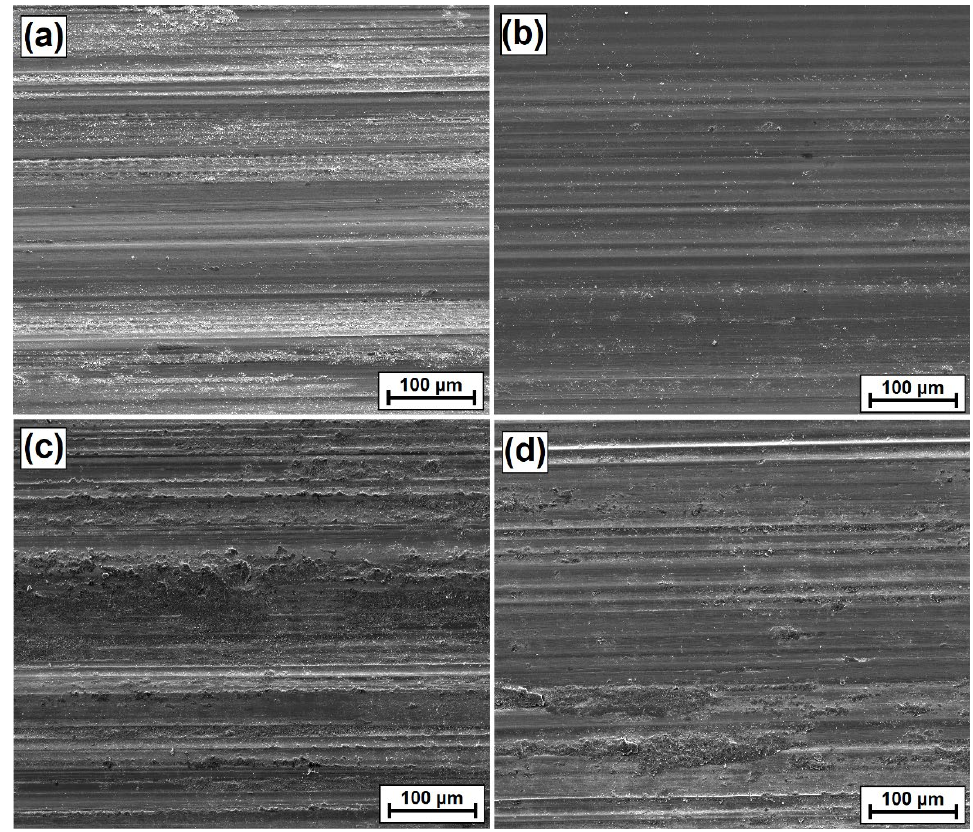
Figure 10. Surface images obtained after a wear resistance test: ( a ) substrate after hardened and tempered processes, ( b ) coating produced by 500 W, ( c ) coating produced by 900, ( d ) coating produced by 1100 W. All photos were taken in SE contrast, in high vacuum at a voltage of 10 kV .